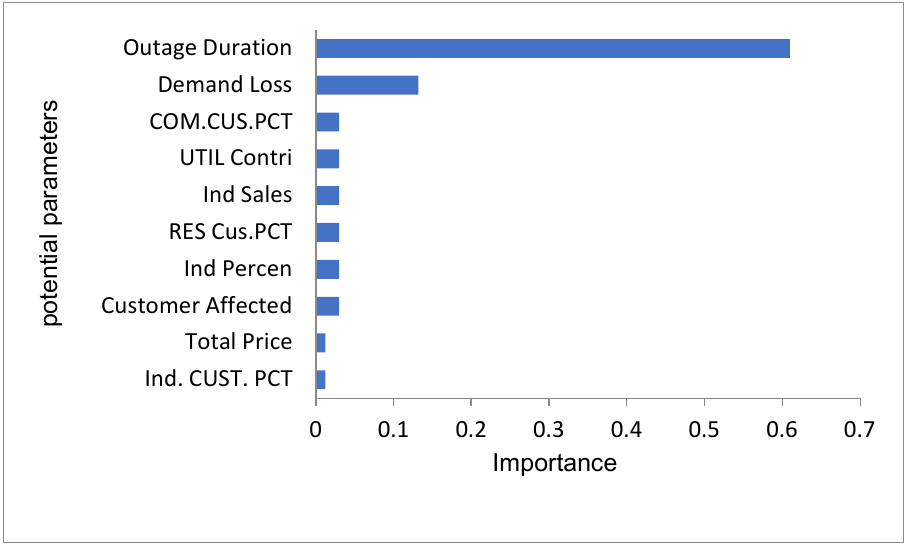
Figure 26. Top 10 influential feature ranking for revenue loss prediction in the heavy wind category. Figure 27 shows inter-feature correlations for the top five important features.